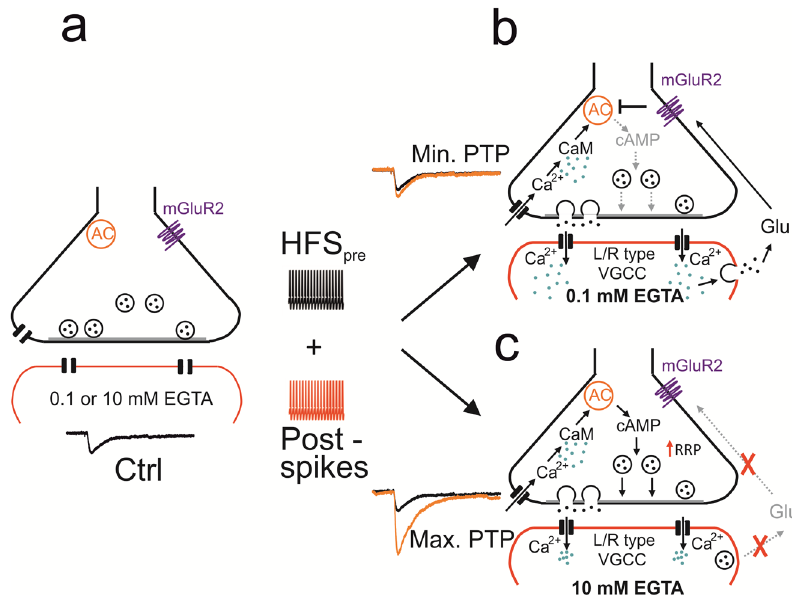
Fig. 5 Mechanisms of PTP and possible signaling pathways underlying transsynaptic modulation at the MFB – CA3 pyramidal neuron synapse. a MFB – CA3 synapse during resting conditions. Presynaptic terminal in black on top, postsynaptic compartment in red at the bottom. AC stands for adenylyl cyclase, mGluR2 indicates extrasynaptic metabotropic glutamate receptor 2 (and mGluR3 expressed at lower levels). b MFB – CA3 synapse after tetanic stimulation, leading to postsynaptic activity, in the presence of low (0.1 mM) concentrations of the Ca 2 + chelator EGTA in the postsynaptic cell. CaM stands for calmodulin, VGCC for voltage-gated Ca 2 + channels, and Glu for glutamate. Ca 2 + ions indicated as green dots, glutamate molecules as black dots. Note that in this scenario tetanic stimulation does not trigger PTP, due to retrograde vesicular glutamate signaling. c Same as for b but in the presence of high concentration (10 mM) of the Ca 2 + chelator EGTA in the postsynaptic cell. Note that in this scenario tetanic stimulation does trigger PTP, due to the lack of retrograde vesicular glutamate signaling. Transsynaptic modulation of PTP induction may not only occur with the exogenous Ca 2 + chelator EGTA, but also with endogenous Ca 2 + buffers expressed in the postsynaptic neurons. This may convey both anti-associativity and target cell- speci fi city to the PTP induction mechanism 51